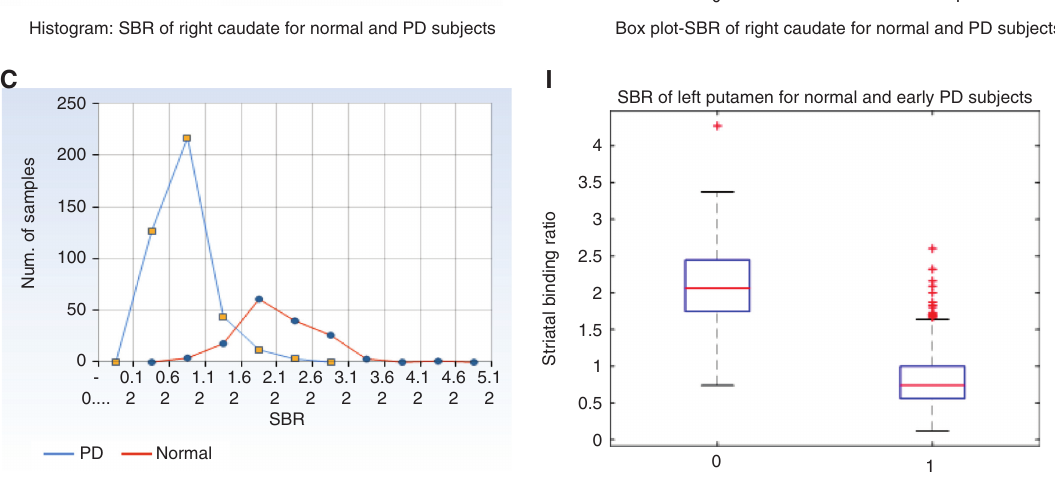
Box plot-SBR of left putamen for normal and PD subjects Figure 2: Histogram and Box Plots of SBR Values for Left Caudate (A, G), Right Caudate (B, H), Left Putamen (C, I), Right Putamen (D, J), CSF Biomarker (E, K), and Urine Biomarker (F, L) for PD and Normal Subjects